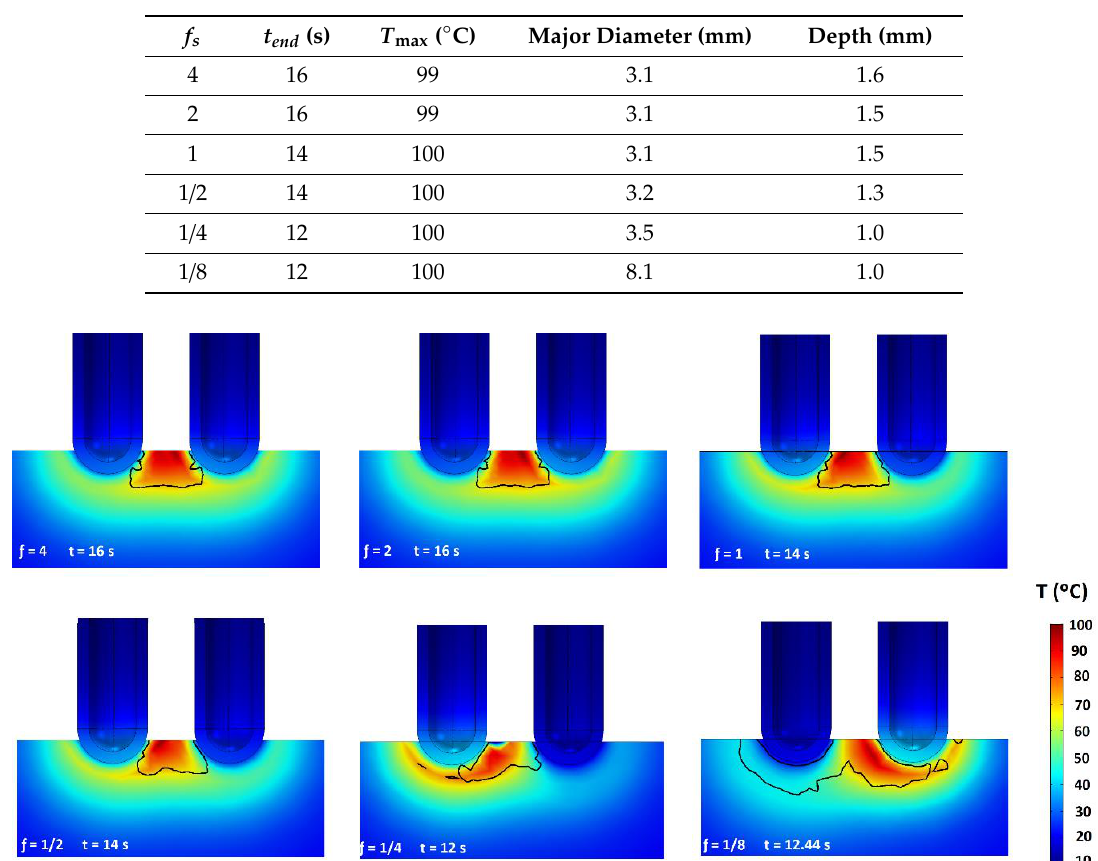
Figure 8. Temperature distribution (°C) and isosurface Ω = 1 (black line) for the SMM (45 V) in the symmetry plane of the geometry representing cases of f S = 4, 2, 1, 1/2, 1/4, and 1/8. The times in each graph are the times that satisfied the stop criterion.